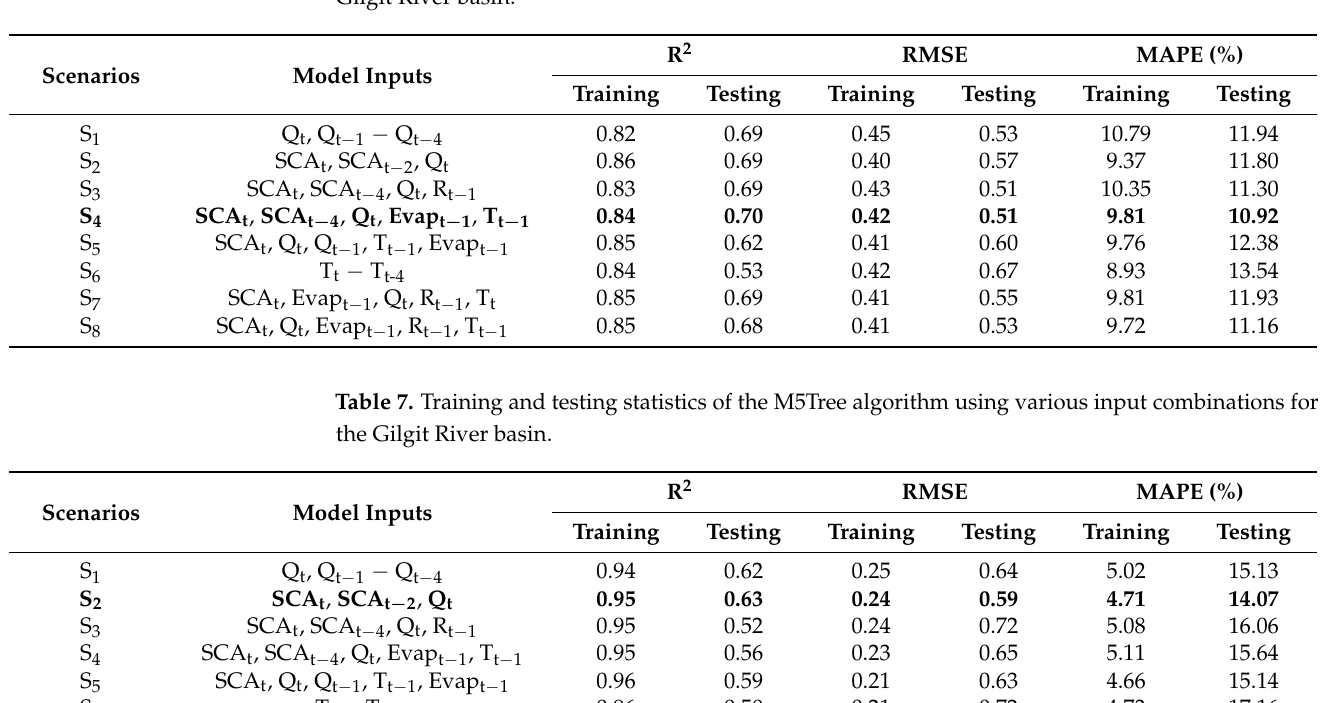
Table 6. Training and testing statistics of the SVR algorithm using various input combinations for the Gilgit River basin.